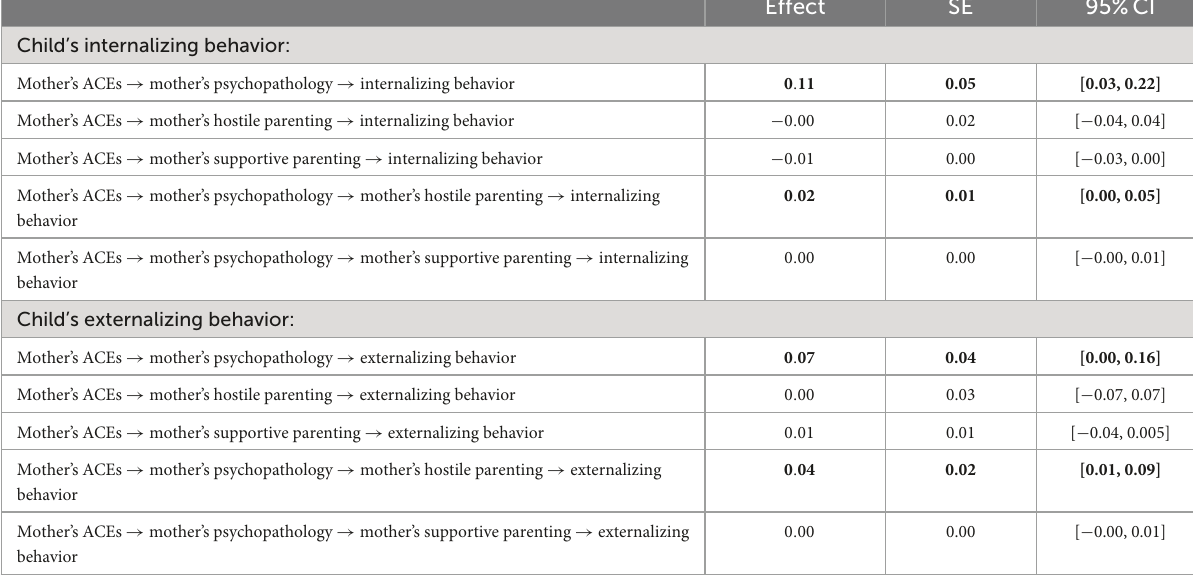
TABLE 2 Indirect paths between mother’s adverse childhood experiences (ACEs) and child’s behavior via mother’s psychopathology and parenting. Effect SE 95%